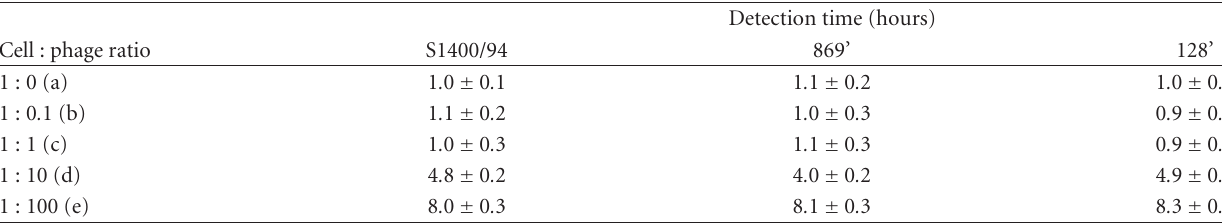
Table 3: E ff ect of cell to phage ratio on detection times.